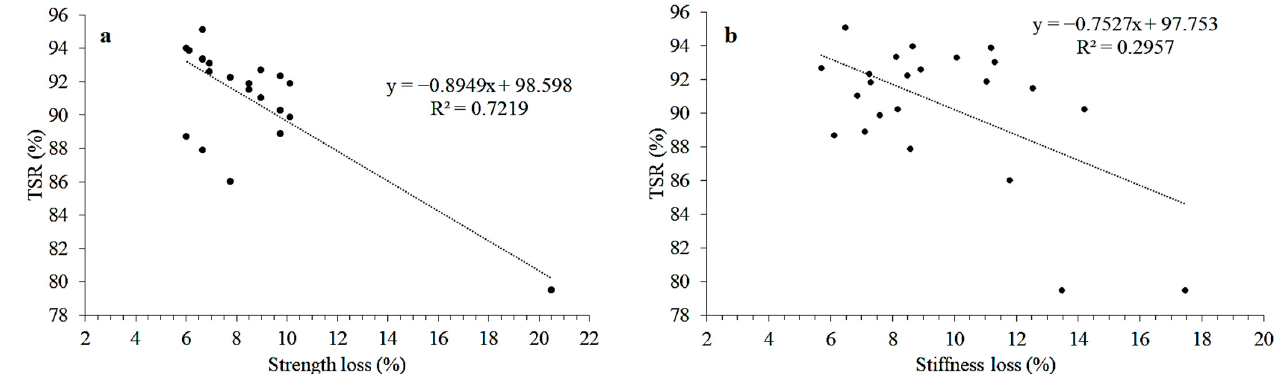
Table 3. Single- Factor ANOVA test .